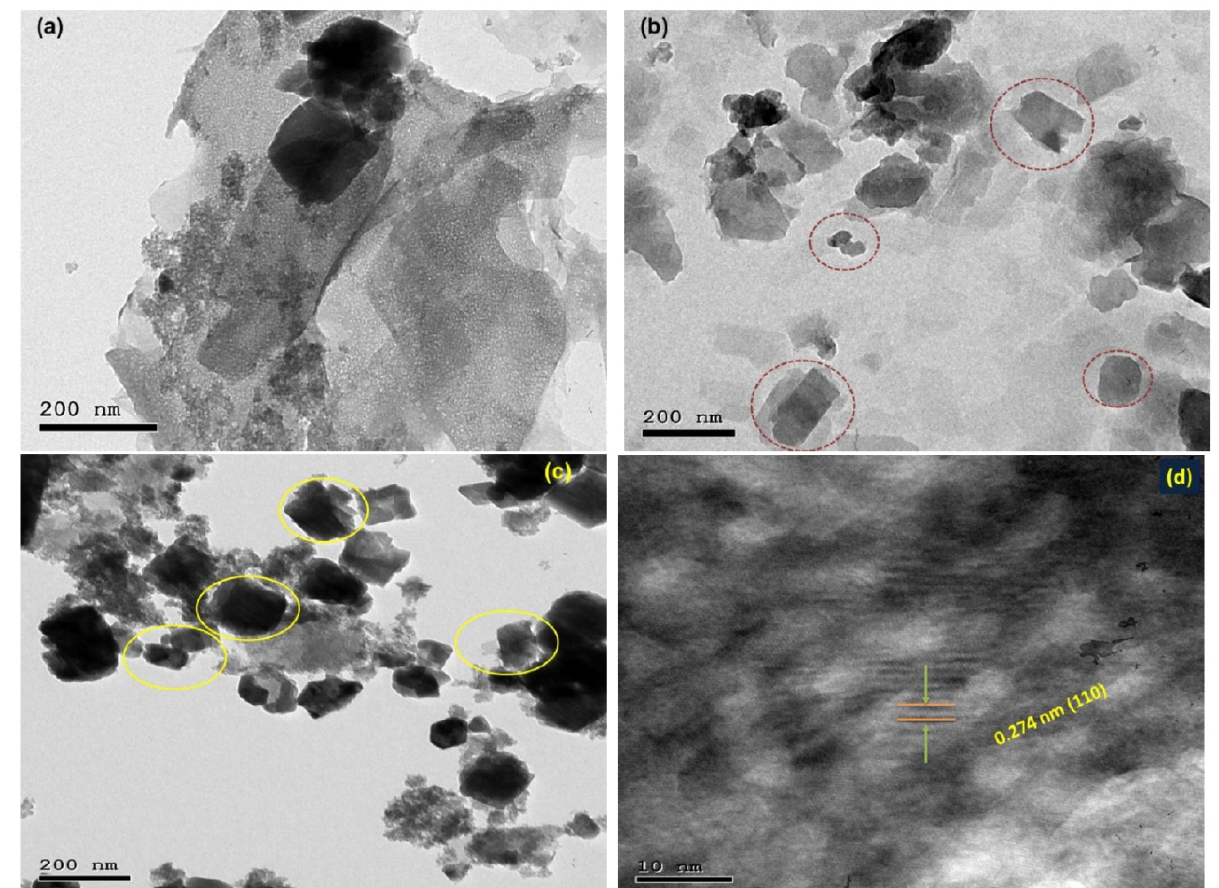
Figure 5. HRTEM images of the prepared Zn-Fe LDH ( a ), zeolite ( b ) and zeolite/Zn-Fe LDH ( c ) and in situ magnification for the Zn-Fe LDH ( d ). Table 3. The results of BET analyses for the synthesized samples; PV and APD are pore volume and average pore diameters.